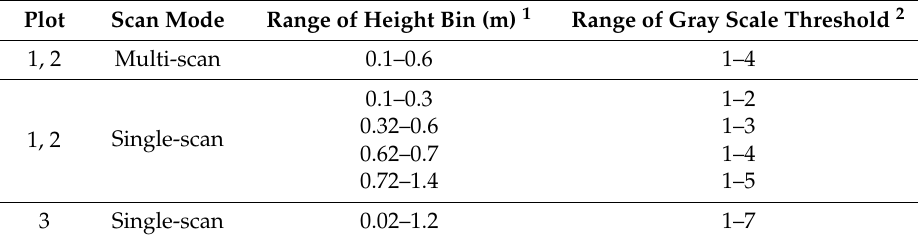
Table 2. Range of height bin and gray scale threshold in different plots and scan